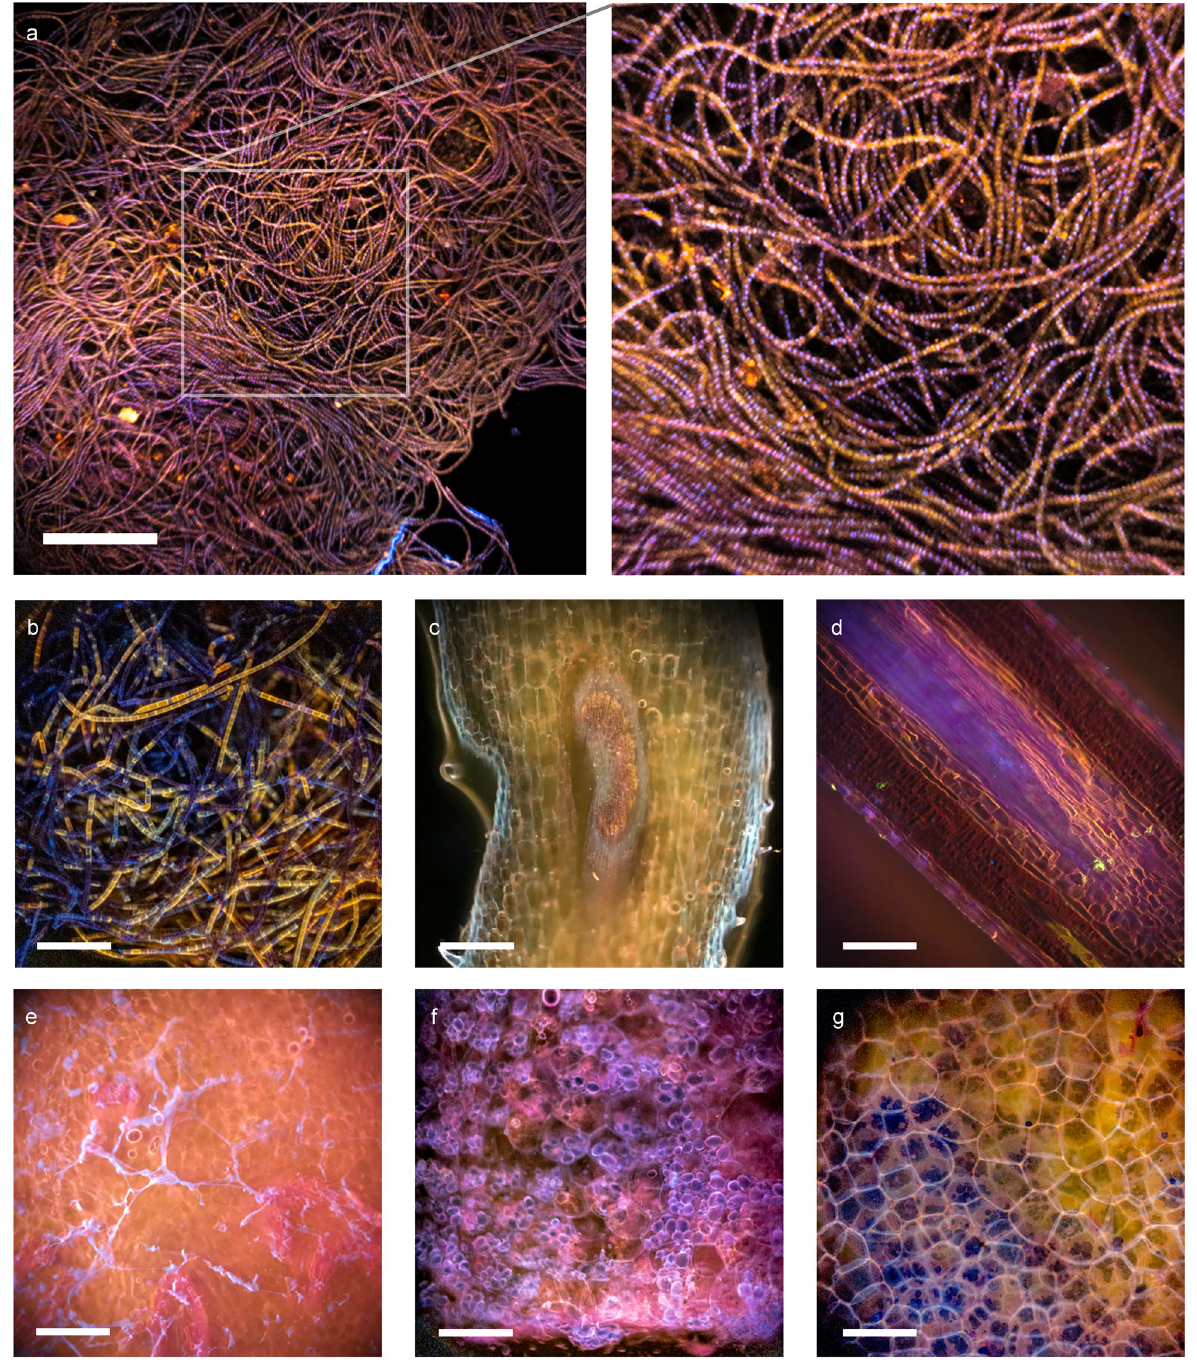
Fig. 6 Images of plant samples acquired with Pocket MUSE. a A cluster of fi lamentous algae stained with 0.05% w/v rhodamine B and 0.01% w/v DAPI. A close-up view of the region labeled with the box (box size: 600 × 600 µ m 2 ) is shown on the right. b A cluster of different fi lamentous algae, ( c ) a cross- section of a clover stem, ( d ) a cross-section of a pine needle, ( e ) a cross-section of onion, and ( f ), ( g ) cross-sections of potato stained with the same rhodamine B and DAPI solution. The potato slice in ( g ) is further washed in saturated iodine water. The stain effectively created a large variety of structural contrast in different plant samples. In general, rhodamine B has a high af fi nity to xylem structures ( c ) and ( e ), while DAPI stains carbohydrate abundant structures such as cell walls ( c ), and ( f ), root saps ( e ), and starch granules ( f ). In the fi lamentous algae sample ( b ), rhodamine B appears to have a higher af fi nity to some algae cells (appears yellow), while some cells are only stained with DAPI (appears blue). Starch granules are stained in black by elemental iodine, indicating absorptive stains may work collaboratively with fl uorescent stains under MUSE contrast. Scale bars: 300 µ